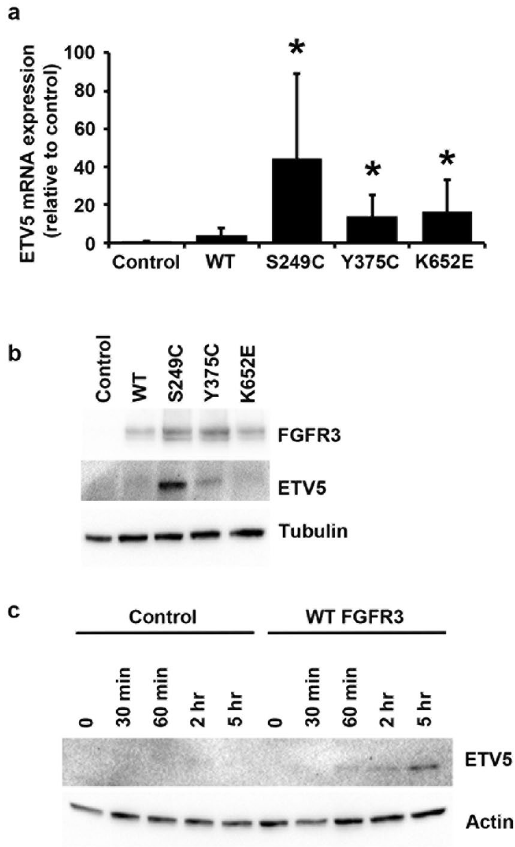
Figure 1. FGFR3-mediated regulation of ETV5 expression. ( a ) ETV5 mRNA and ( b ) ETV5 and FGFR3 protein levels in confluent TERT-NHUC with exogenous overexpression of wildtype (WT) or three types of mutant FGFR3 (S249C, Y375C, and K652E), and in control cells transduced with an empty vector (Control); ( c ) ETV5 protein levels following FGF1 treatment of TERT-NHUC overexpressing wildtype (WT) FGFR3 and of control cells transduced with the empty vector (Control). ETV5 mRNA was relatively quantified using Taqman Real- Time RT-PCR with SDHA as internal control, while ETV5 and FGFR3 proteins were visualized by western blotting with specific antibodies using alpha-tubulin or beta-actin as loading control. All experiments were repeated in triplicate. ‘ * ’ indicates a statistical significant difference compared with the control